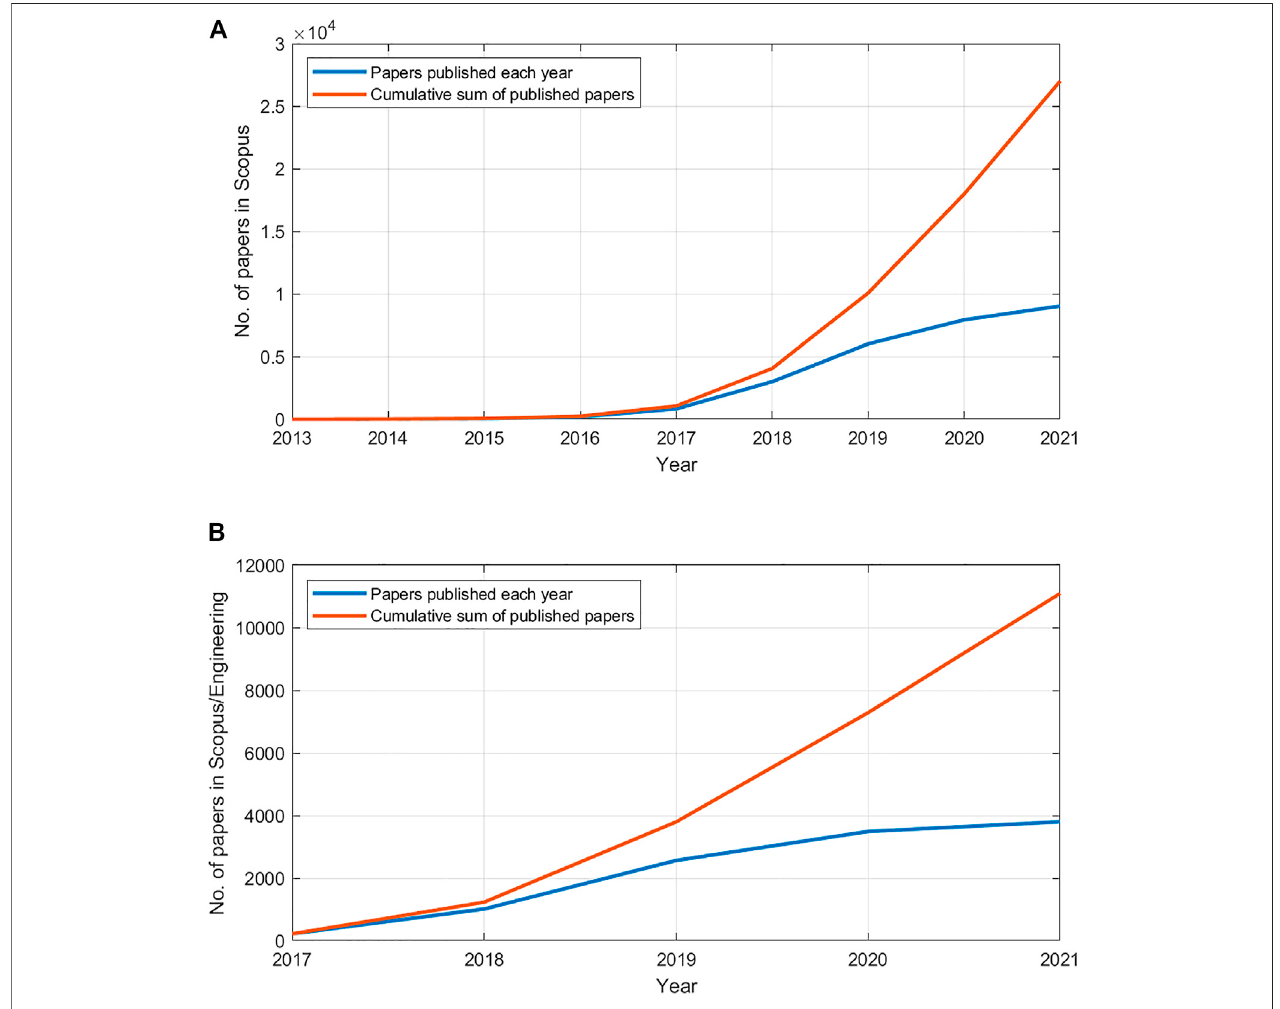
FIGURE 1 | Papers in “ blockchain ” in Scopus database, per year: (A) General search (all fi elds), (B) Search limited within the “ Engineering ” fi eld.